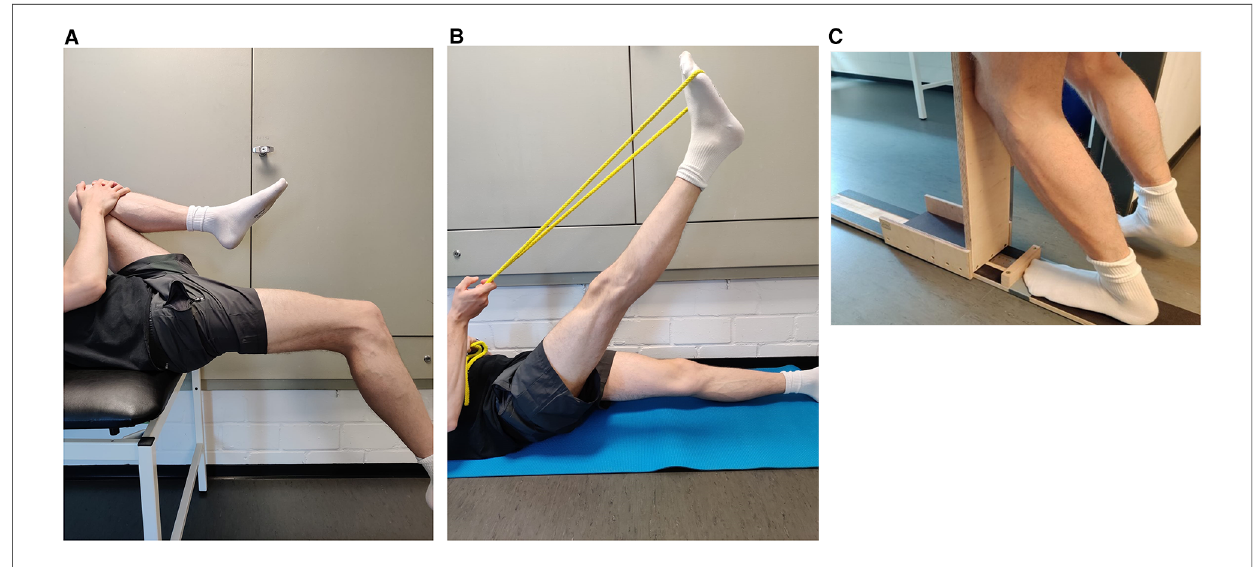
FIGURE 1 Flexibility tests of the knee joint ( A ), hamstrings muscles ( B ), and ankle joint ( C